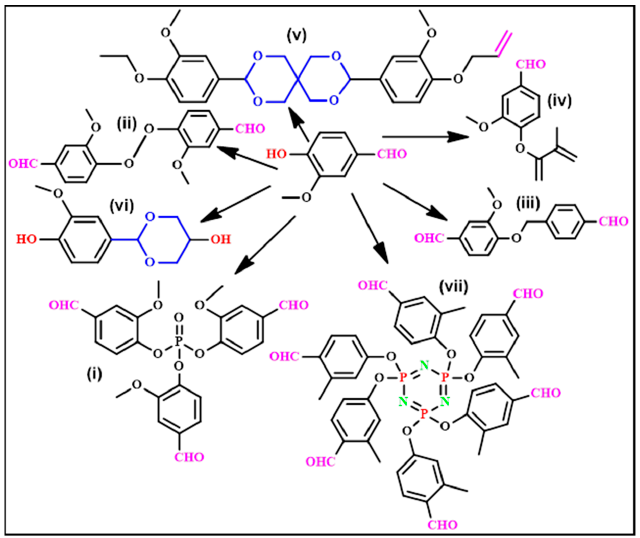
Figure 7. Vanillin modification methods for producing thermoset vitrimers. Table 2. Thermal and mechanical properties as well as recycling conditions of vanillin-modified vitrimers.